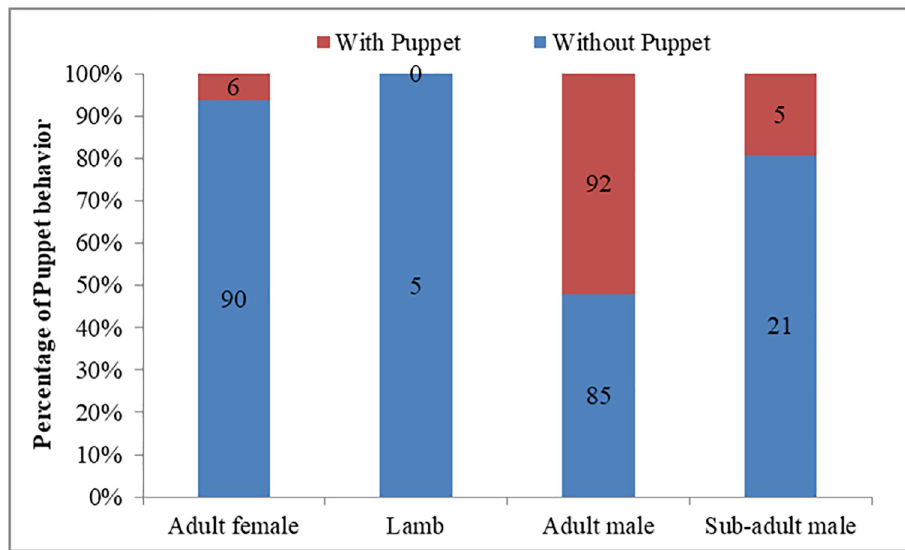
Fig 5. Effect of sex-age on the occurrence of Puppet behavior of Tibetan